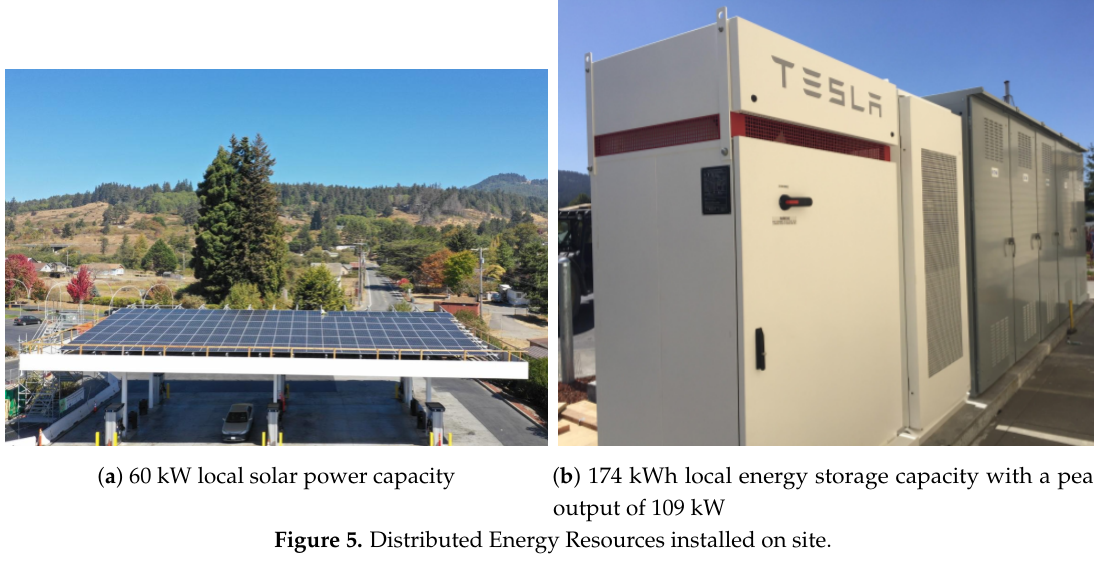
Figure 5. Distributed Energy Resources installed on